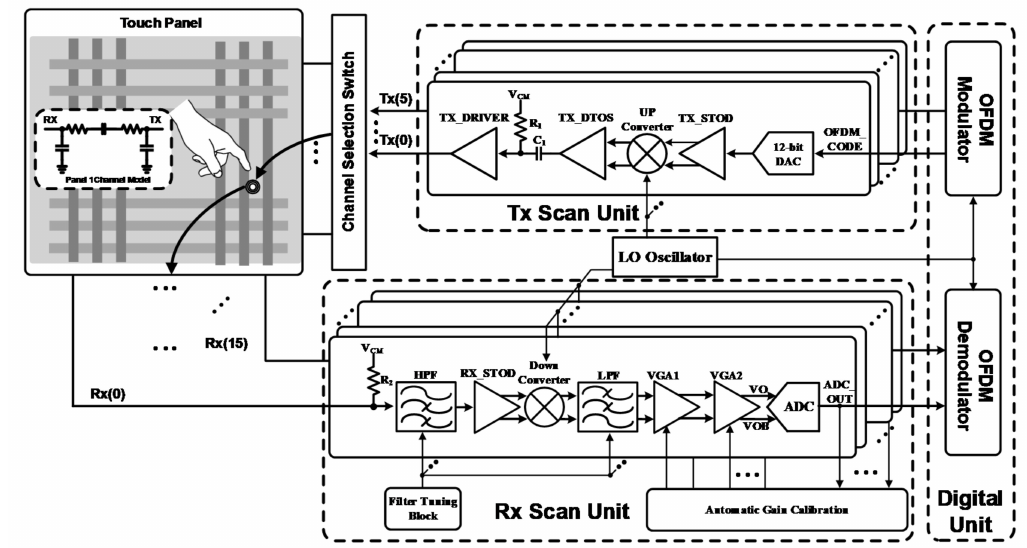
Figure 5. Block diagram of proposed analog front-end for the capacitive touch panel.